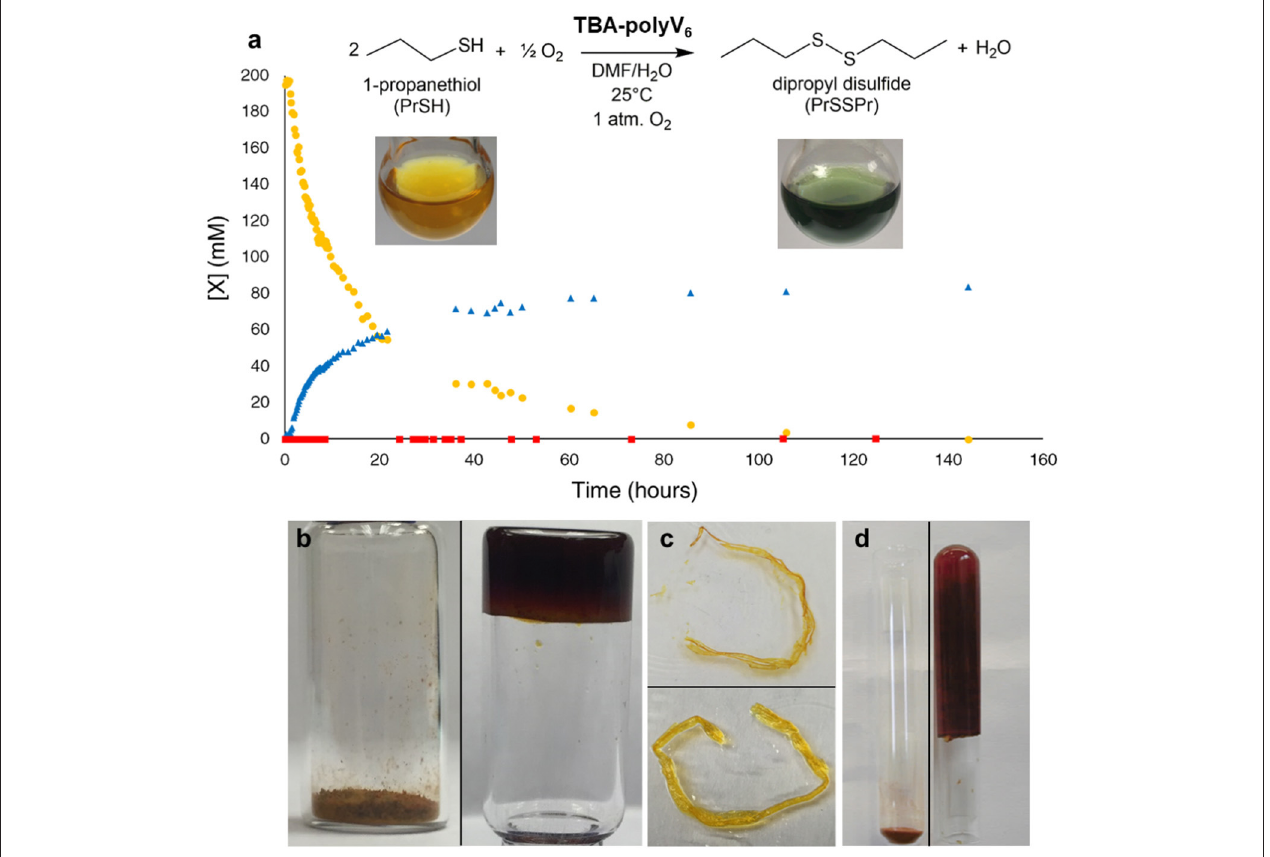
FIGURE 3 | Aerobic oxidation catalyzed by TBA-polyV 6 . ( a ) Oxidation of 1-propanethiol (•) to dipropyl disulfide ( N ) catalyzed by TBA-polyV 6 . The molar ratio was 127 1-propanethiol: 1 V 6 . A control reaction ( (cid:4) ) was run under identical conditions but without TBA-polyV 6 . Inset : A yellow dispersion of TBA-polyV 6 in DMF before (left) and after (right) addition of 1-propanethiol (Figure 4.) ( b ) Swelling of TBA-polyV 6 (left) in the presence of dimethyl methyl phosphonate (DMMP) (right). (c) A strand of TBA-polyV 6 before (above) and after (below) addition of DMSO. (c) Swelling of TBA-polyV 6 (left) in the presence of DMF (right). (d) Swelling behavior measured in mL of liquid per gram of material after 24-hour exposure. Reproduced from (Sullivan et al., 2017) with permission from the Royal Society of Chemistry.